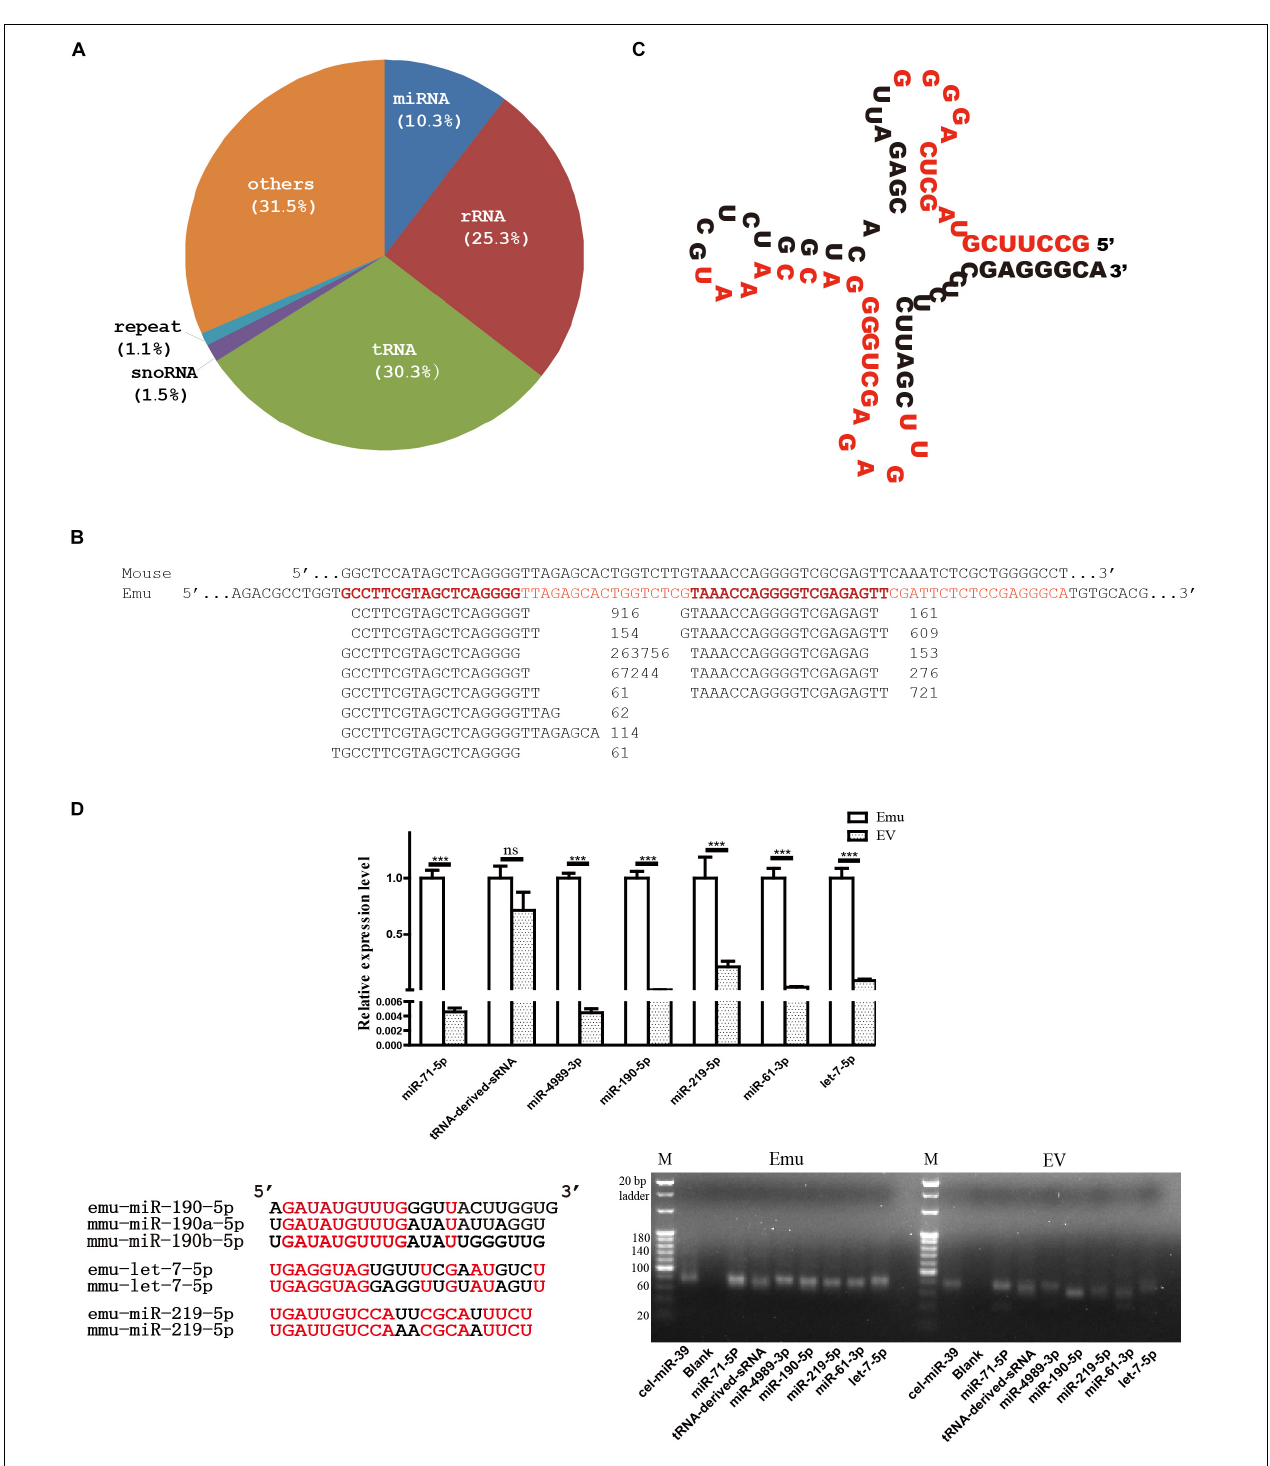
FIGURE 1 | Small RNA profile of E. multilocularis extracellular vesicles. (A) Catalogs of small RNA identified. (B) Alignment of threonine tRNA-derived small RNAs. Short reads were aligned beneath the threonine tRNA gene of E. multilocularis (Emu, in red), and read counts were placed after each sequence. For comparison, mouse threonine tRNA gene (Mouse) was aligned together. (C) Secondary structure of threonine tRNA gene of E. multilocularis . Two short sequences with the highest read count in each of two mapped read sets were highlighted in red. (D) qPCR validation and electrophoresis of tRNA-derived small RNA (sRNA) and six miRNAs. Using C. elegans miR-39 as a exogenous reference, their abundance was comparatively evaluated in both E. multilocularis metacestodes (Emu) and extracellular vesicles (EV). Of six E. multilocularis miRNAs, only three, including emu-miR-190-5p, emu-let-7-5p and emu-219-5p, have orthologs in mice and the identical nucleotides are shown in red in the alignment. ∗∗∗ p < 0.001, NS: not significant.